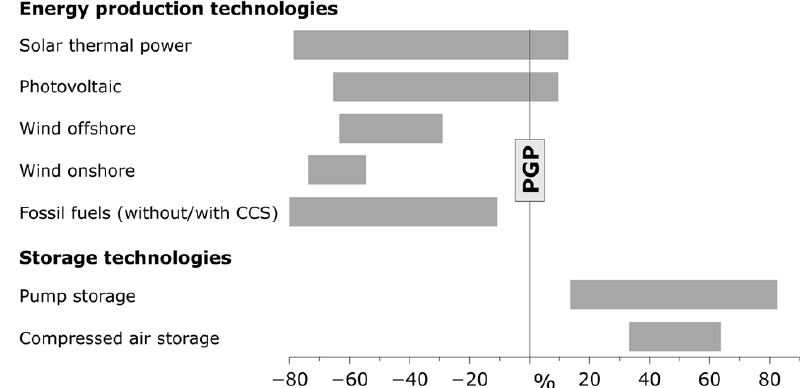
Figure 2. PGP COE (20 eurocents per kWh) compared to global levelized cost bandwidths for fossil fuel and renewable energy production as well as large-grid scale energy storage technologies costs (REN21, 2017; Höfling, 2016; IRENA,